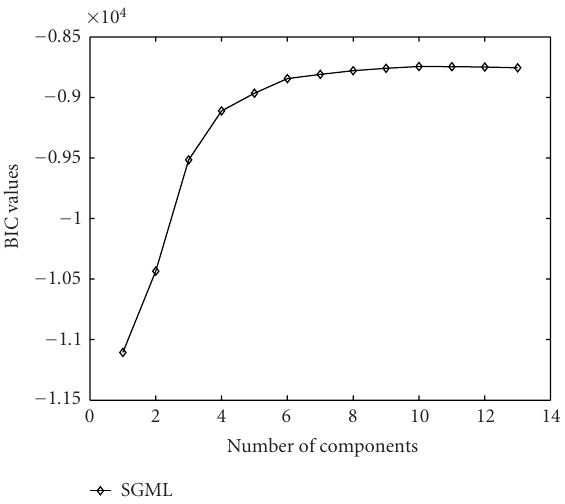
Figure 3: The learning curve of applying the SGML in the synthetic data to learn diagonal covariance